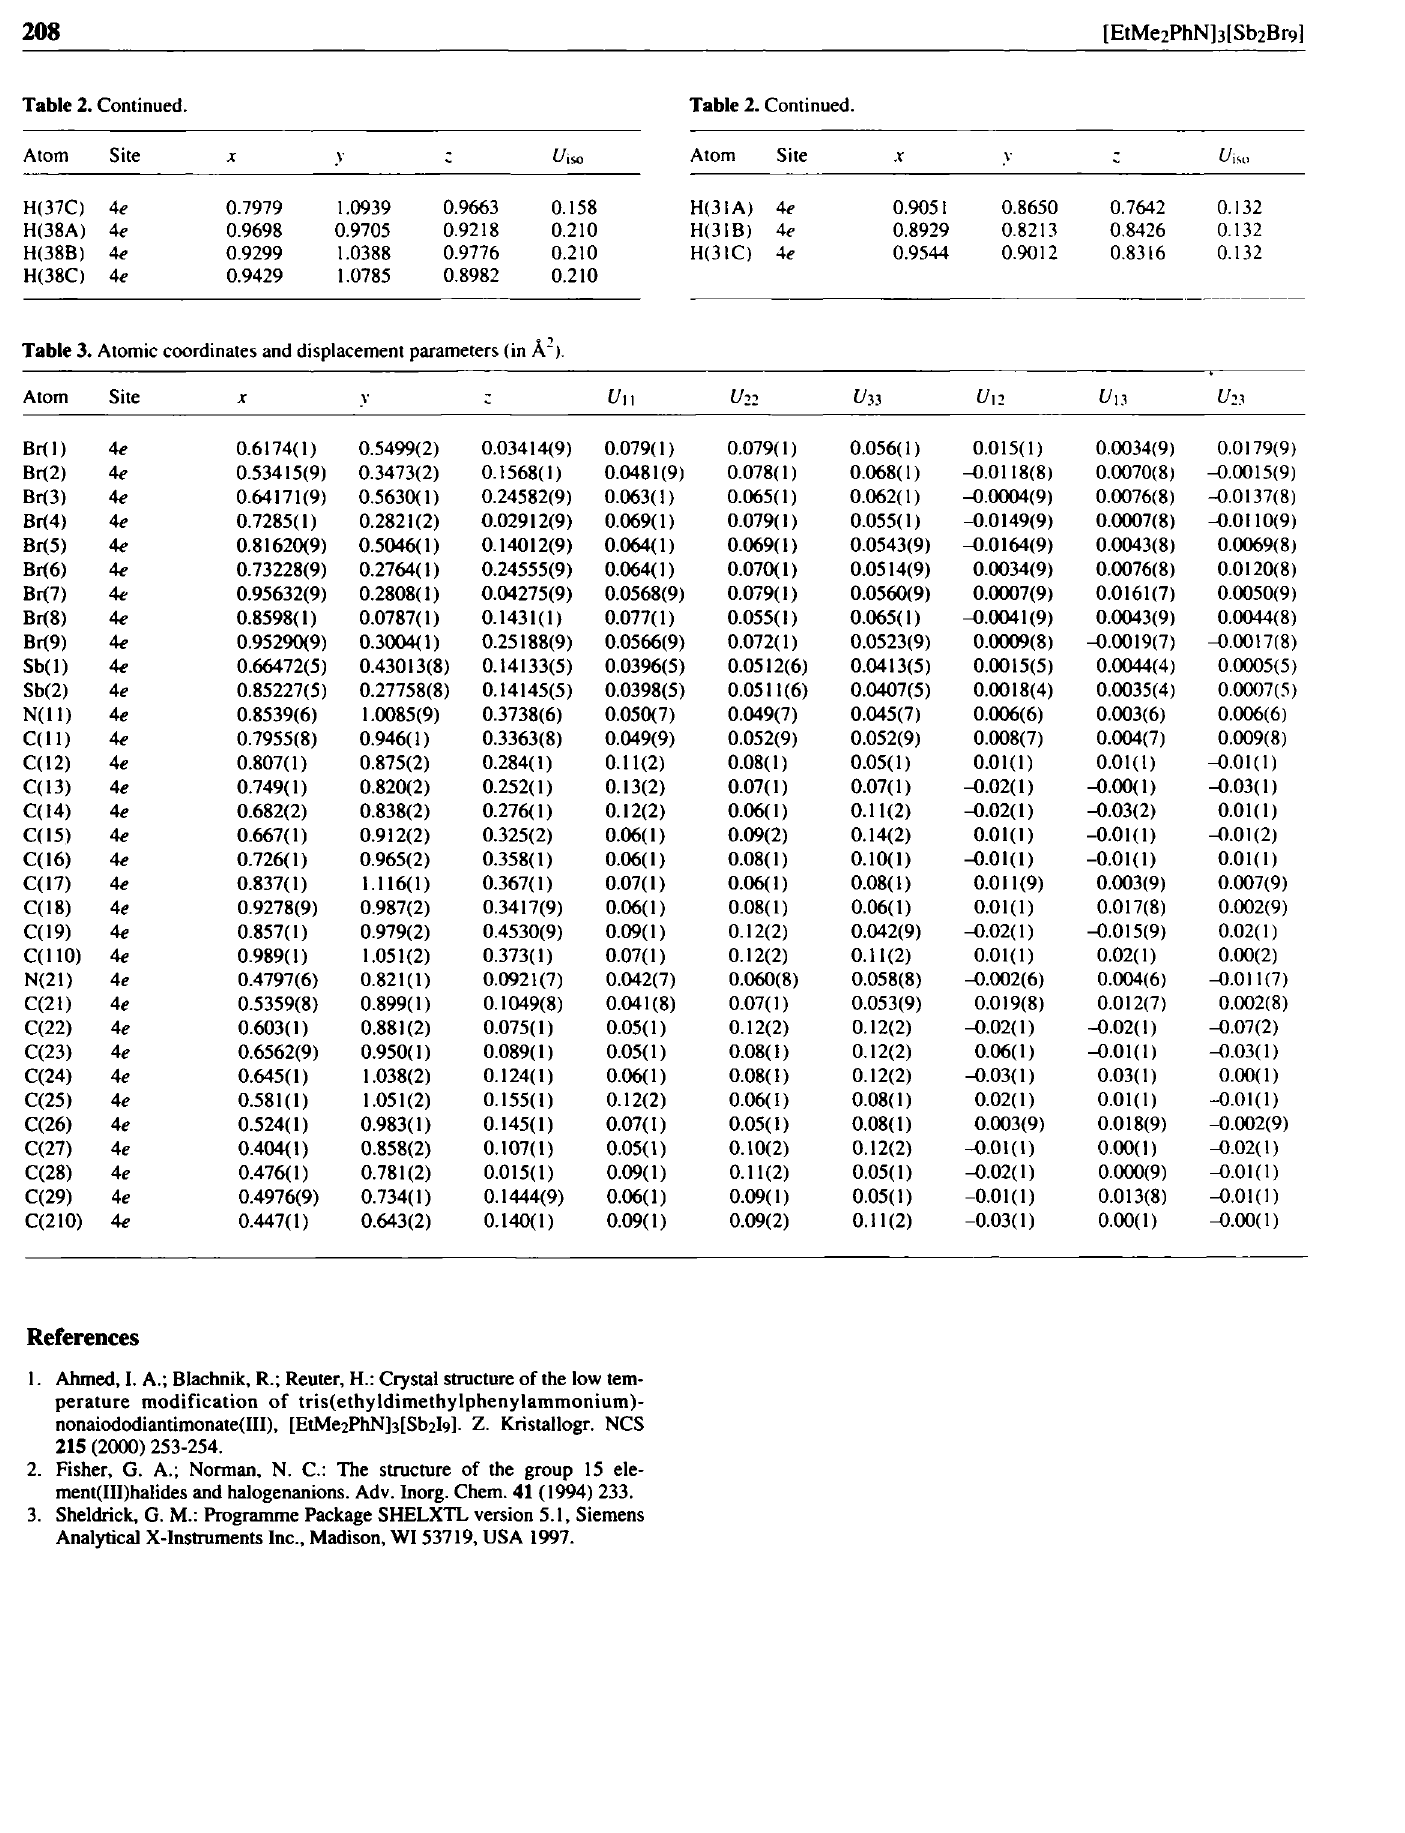
Table 3. Atomic coordinates and displacement parameters (in Ä 2